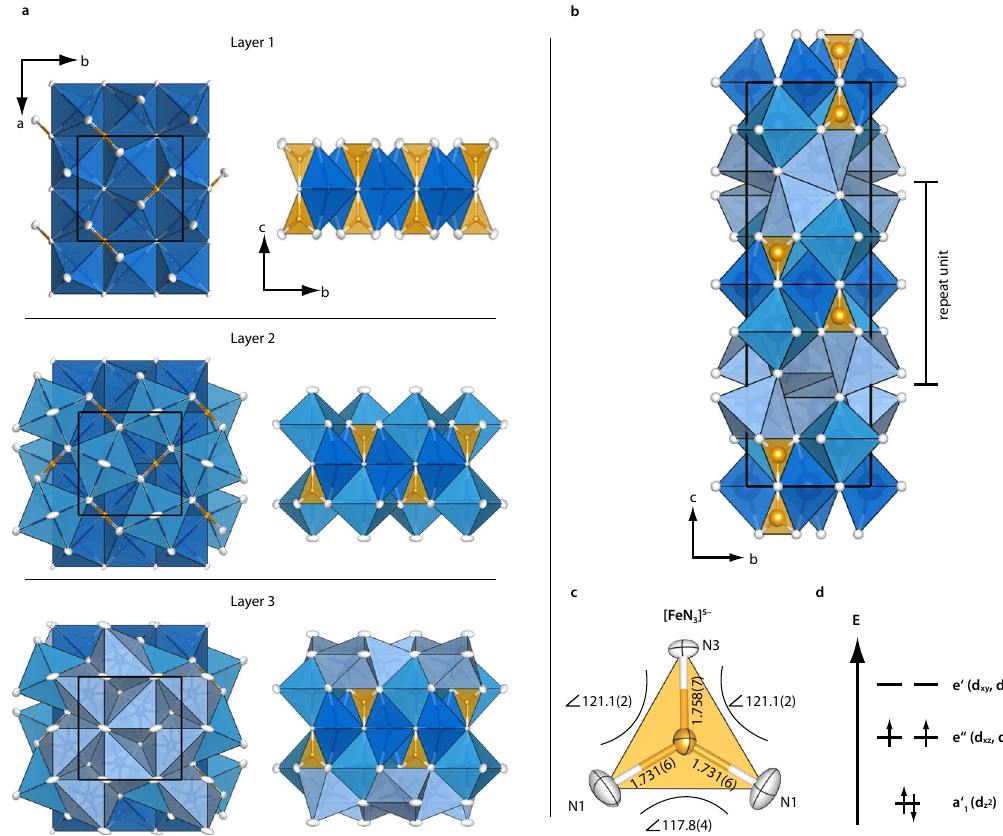
Fig. 1 Structure of Ca 4 FeN 4 . a Formal construction of the repeat unit, which can be subdivided into three layers. Layer 1 is formed by Ca1N 6 octahedra and [FeN 3 ] 5 − polygons, layer 2 is formed by Ca2N 6 octahedra, and layer 3 by Ca3N 6 octahedra. The repeat unit is created by stacking of the layers above and below layer 1, with an inversion centre in the middle of layer 1. b Structure of Ca 4 FeN 4 with inequivalent Ca positions coloured differently, highlighting the repeat unit. c [FeN 3 ] 5 − complex anion showing bond lengths (in Å) and N – Fe – N bond angles (in deg.). Ellipsoids at 95 % probability. d Qualitative d-orbital splitting vs. energy for the [FeN 3 ] 5 − complex anion with double-faced π -donor N-ligands and d 4 electron con fi guration with S = 1 (adapted from literature) 43 .